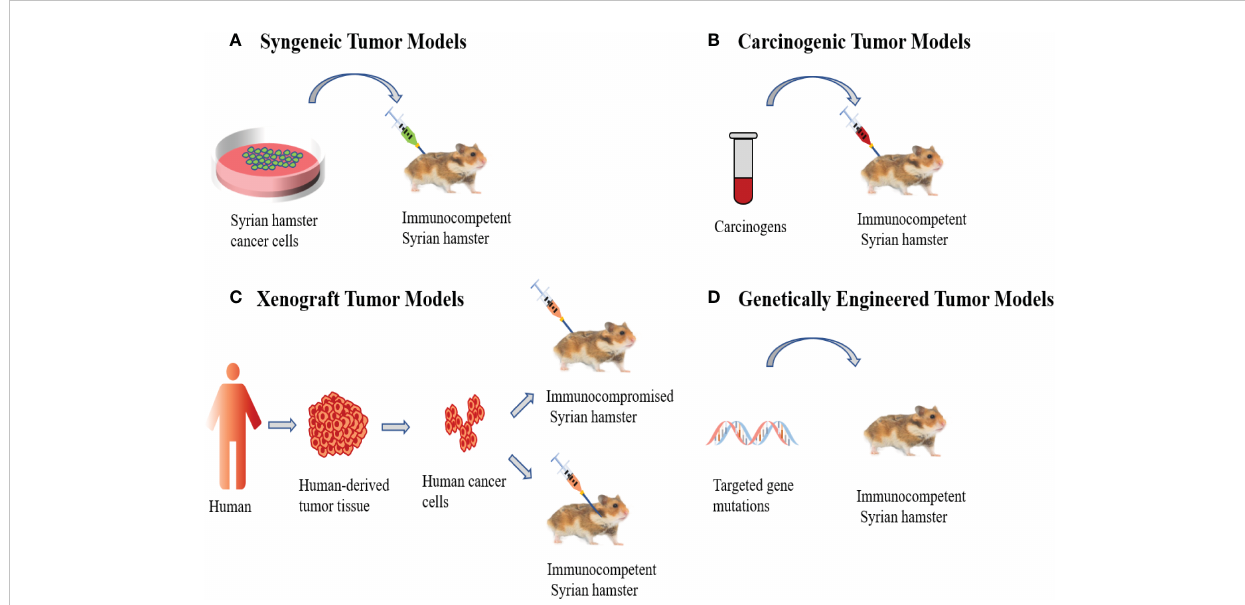
FIGURE 1 Syrian Hamster Tumor Models. (A) Syngeneic tumor models involve the transplantation of in vitro cultured Syrian hamster cancer cells into immunocompetent Syrian hamsters. (B) Carcinogenic tumor models are induced by carcinogens, which allows tumors to undergo de novo formation. (C) Human xenograft tumor models utilize human cancer cells to inject into immunocompromised Syrian hamsters or the cheek pouches of immunocompetent Syrian hamsters. (D) Genetically engineered models are the application of genetic engineering techniques to modify hamster genes to induce cancer